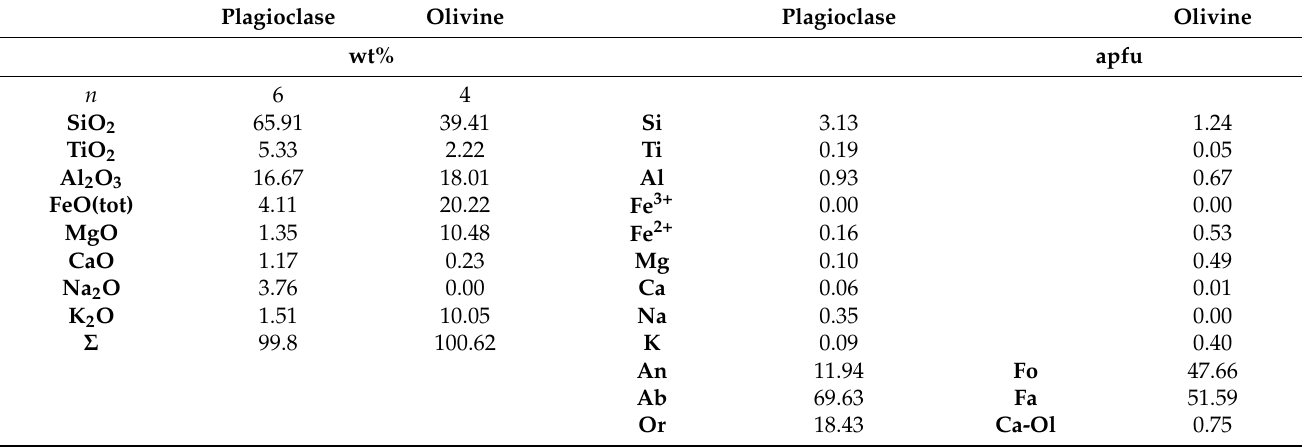
Figure 3. Backscattered scanning electron (BSE) images of sample SV 1-A. ( a ) hercynite and quartz crystals are widespread as remnant minerals from the source material; ( b ) skeletal-dendritic crystals of plagioclase in the glass fraction; ( c ) partially melted olivine; ( d ) fractured crystal of quartz. The average chemical composition of plagioclase and olivine was determined by SEM-EDS (Table 3). The average composition of plagioclase is Ab 69.63 An 11.94 . The average composition of olivine is Fo 36.82 Fa 60.51 . The glass composition was determined by SEM-EDS, as well. It is composed mainly of SiO 2 , Al 2 O 3 , and FeO (tot) in the analyzed areas (Table 4). Table 3. Chemical data for plagioclase and olivine in Serravuda vitrified sample SV 1-A by scanning electron microscopy (SEM) with Energy dispersive X-ray spectroscopy (EDS) analysis. n = number of data